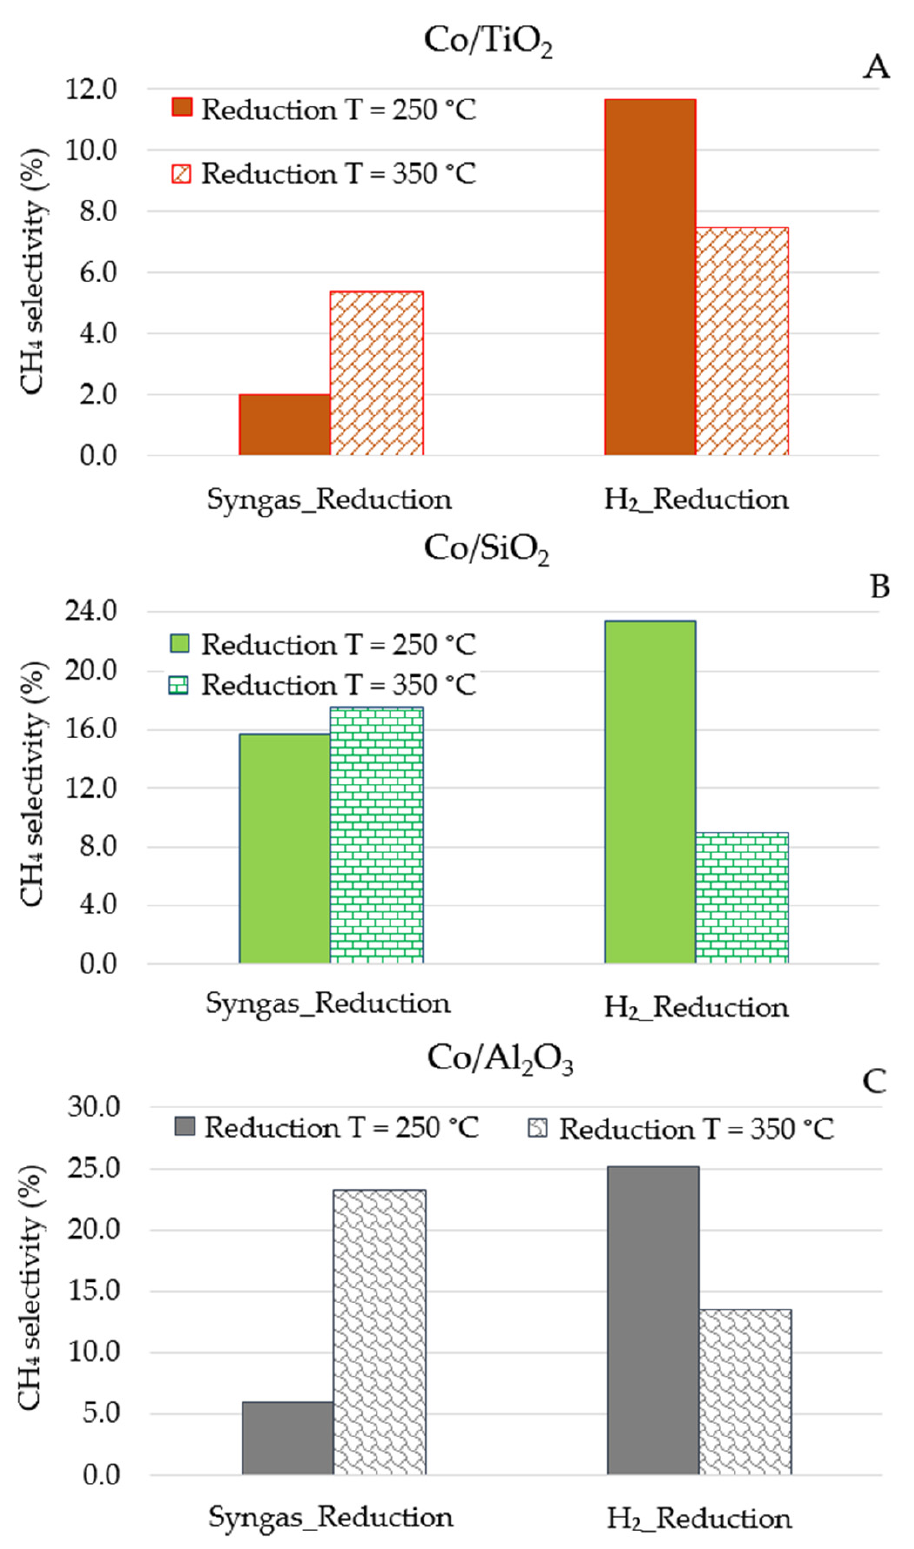
Figure 7. The selectivity of CH 4 as a function of reducing agent and temperature: ( A ) for Co/TiO 2 , ( B ) for Co/SiO 2 , and ( C ) for Co/Al 2 O 3 . Reaction conditions: 20 bar, 60 mL/min, and 210 °C.